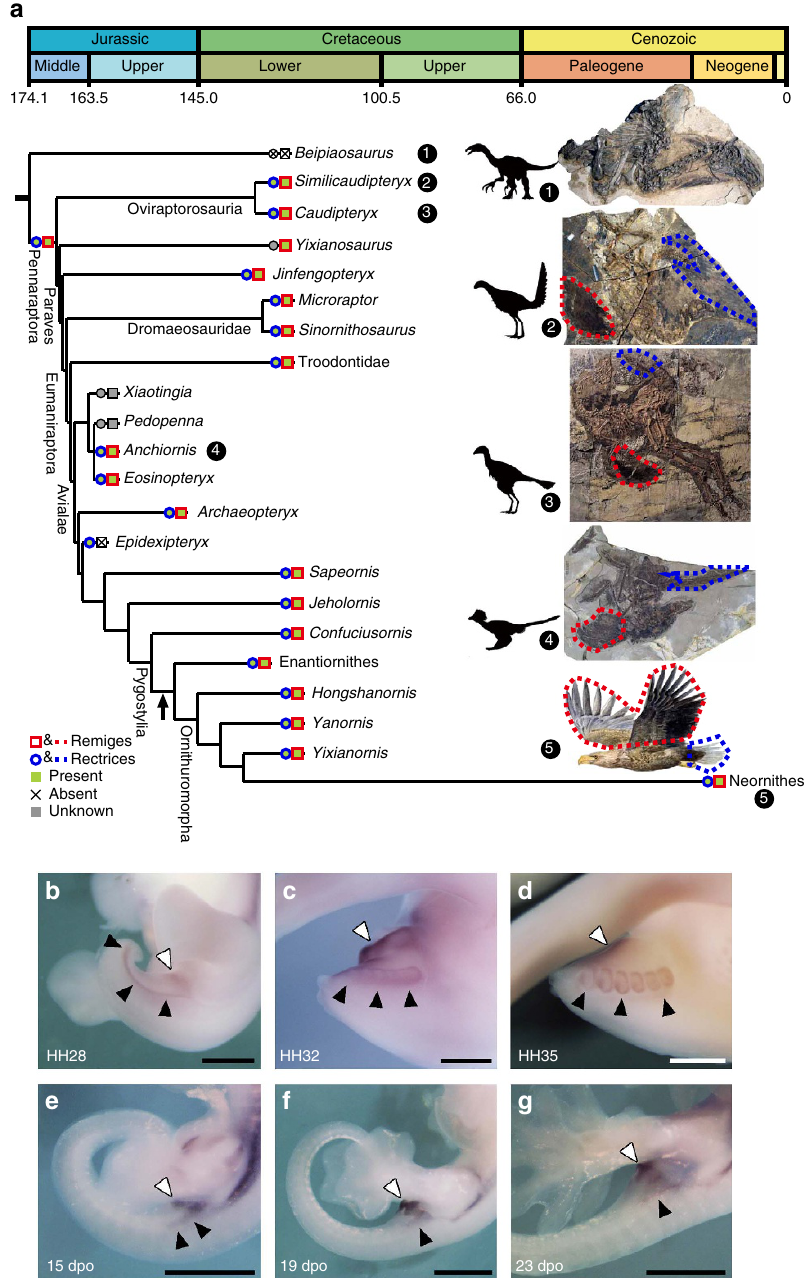
Figure 6 | Sim1 and flight feather evolution. ( a ) Evolution of flight feathers. Character optimization on a calibrated phylogeny indicates that flight feathers (remiges and rectrices) evolved at the base of the Pennaraptora, a clade including oviraptorosaurs, dromaeosaurs, troodontids, and birds, about 170 million years ago. The arrow around the Ornithuromopha branch indicates the estimated time when the Sim1 ASHCE became conserved (144.0Myr ago). This tree is modified from the Fig. 3 in Foth et al 42 . ( b – d ) The expression of Sim1 in the tail of chicken embryo at HH28 ( b ), HH32 ( c ) and HH35 ( d ). ( e – g ) The expression of Sim1 in the tail of gecko embryo at 15 dpo ( e ), 19 dpo ( f ) and 23dpo ( g ). Black and white arrowheads indicate the expression of Sim1 in the lateral side of the tail and the cloaca, respectively. Scale bars, 1mm. Drawing of an eagle in a is reproduced from ref. 10 with permission. All other drawings are original by the